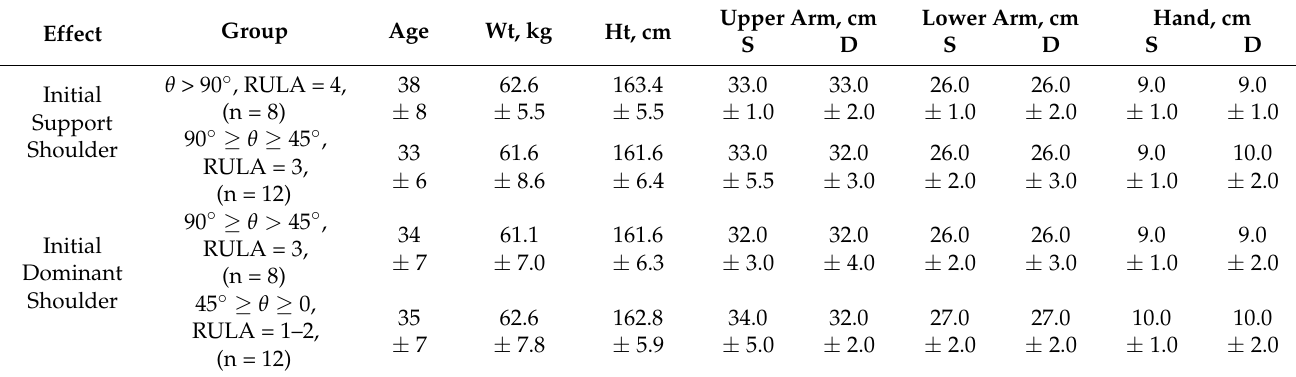
Table 2. Characteristics of the participants by initial shoulder posture (values given as average ± STD; S: supporting arm; D: dominant arm; Wt: weight; Ht: height).